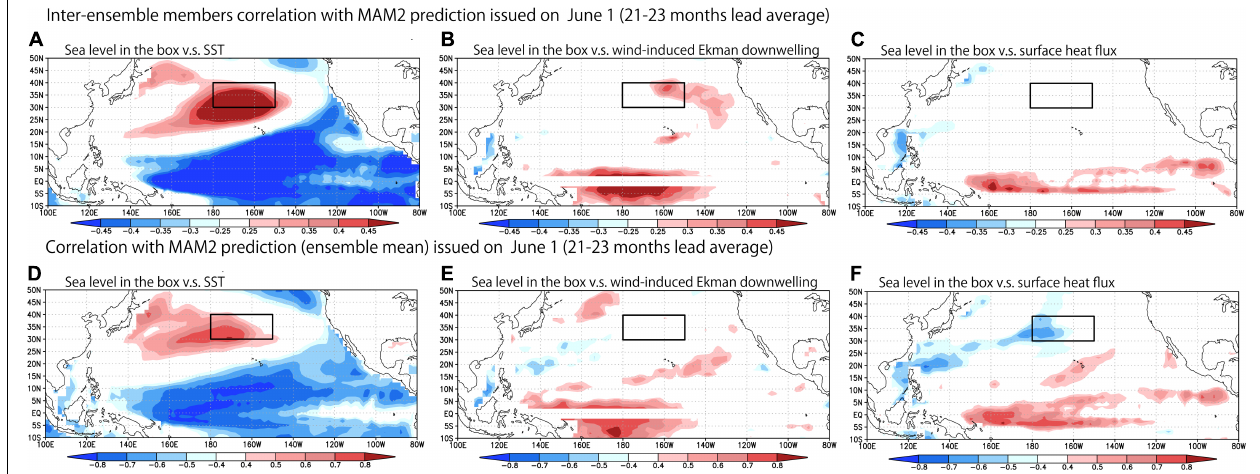
FIGURE 3 | (A) Inter-ensemble member correlation between sea level anomaly averaged in 30 ◦ –40 ◦ N, 180 ◦ –150 ◦ W (shown by a box) and a horizontal distribution of SST anomaly in a nine-member ensemble reforecast for the 21–23 months lead average issued on June 1. (B) Same as (A) , but for regional wind-induced Ekman downwelling. (C) Same as (A) , but for surface heat flux. (D–F) Same as (A–C) , but for correlation using the ensemble mean prediction. The color scale is different from that in (A–C) because the sample size is different (198 and 22). Considering the degree of freedom based on the sample size, the correlation below 0.25 (0.40) is masked out in the upper (lower)